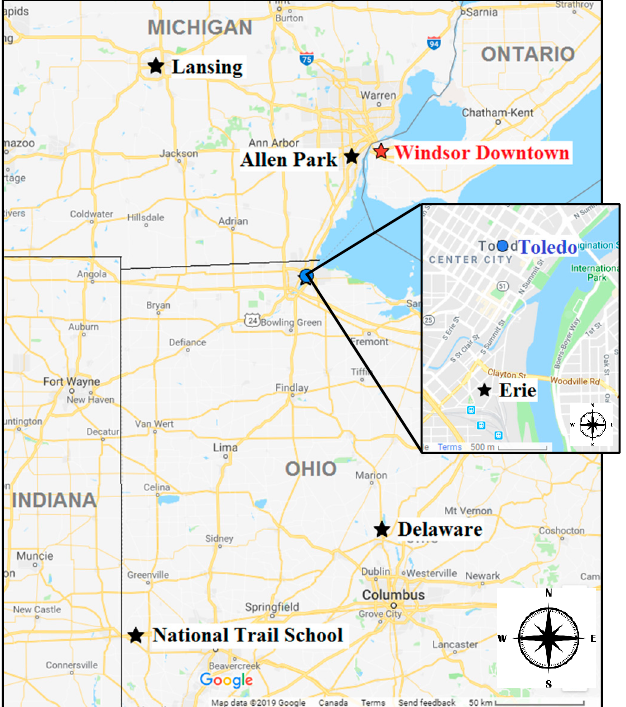
Figure 1. O 3 monitoring at Windsor (red star) and five USA sites (black star) and a weather station in Toledo (blue circle) (base maps adapted from Google Maps, coordinates of monitoring sites from the Ontario Ministry of the Environment, Conservation and Parks (MECP) [27] and United States Environmental Protection Agency (USEPA) [28]).